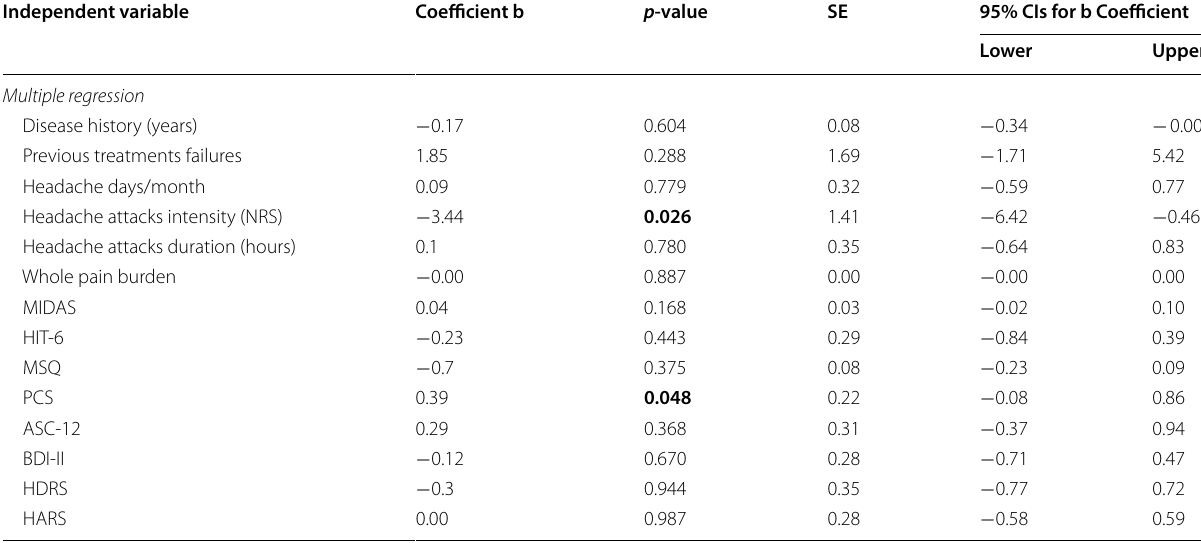
Table 3 Multiple regression analyses assessing which baseline clinical parameters is associated with a better clinical